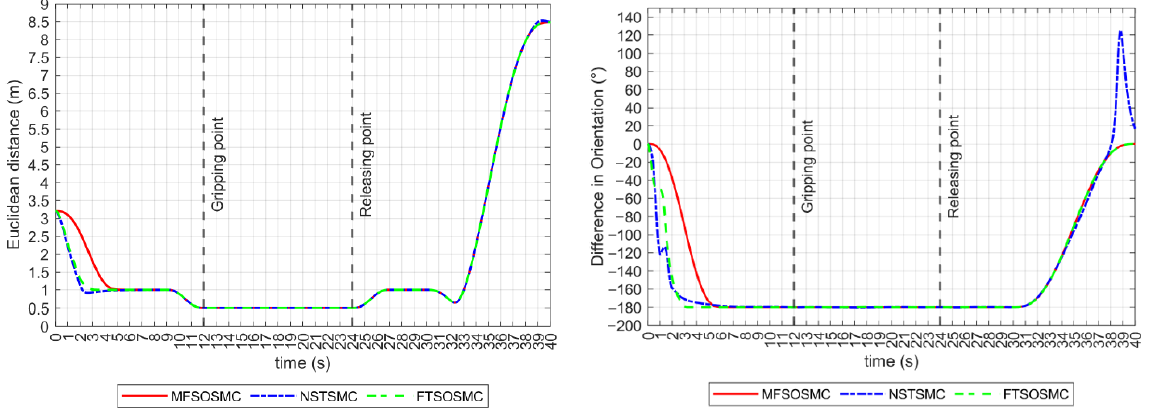
Figure 15. Performance indicators for all the controllers (with external disturbances). Left : Euclidean distance in the 𝑥 axis. Right : relative heading orientation.